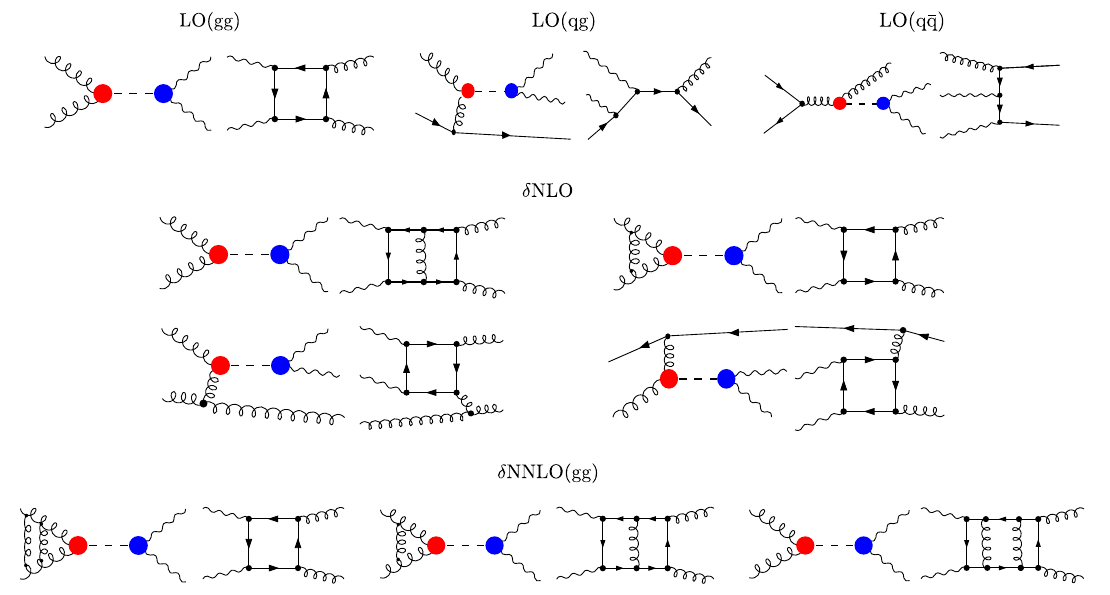
Fig. 2 Representative diagrams contributing to the interference up to order α 4 s . The red dot denotes the effective vertex described through the Lagrangian in Eq. (12), while the blue dot denotes the Higgs decay via heavy quark loops and W boson, described in Eq.